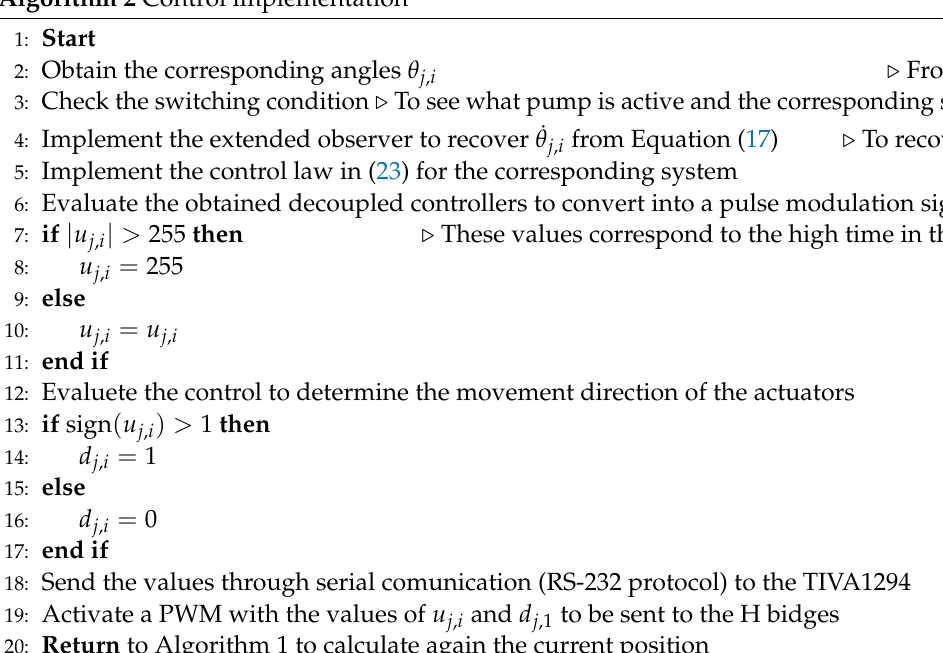
Algorithm 2 Control